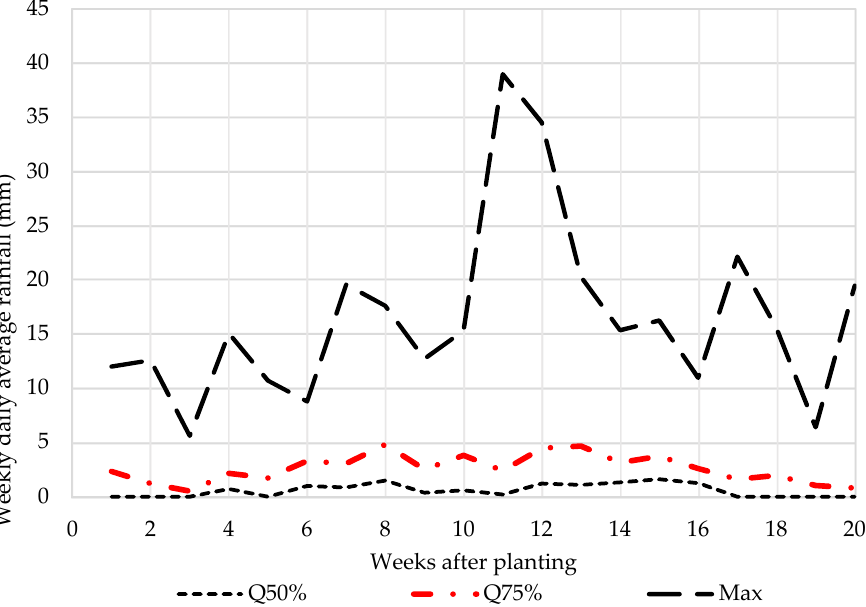
Figure 3. Weekly daily average rainfall for quantiles 50% (Q50%), 75% (Q75%), and maximum (Max) in Vaalharts.